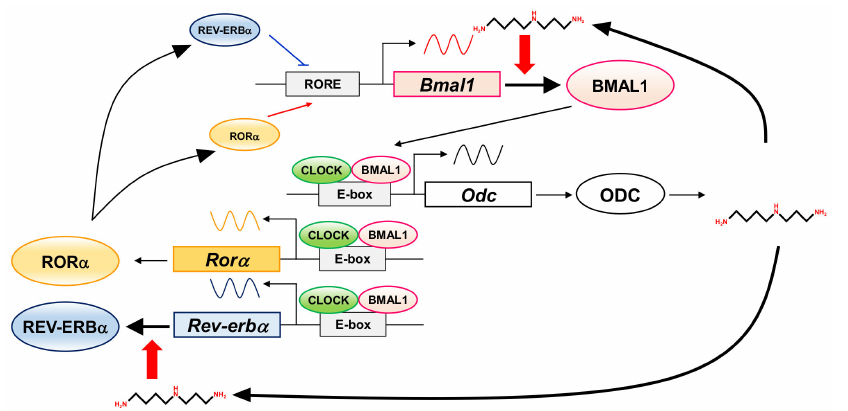
Figure 7. Interrelationship between circadian clock genes and polyamines in the circadian clock. The figure summarizes how circadian clock genes and polyamines are